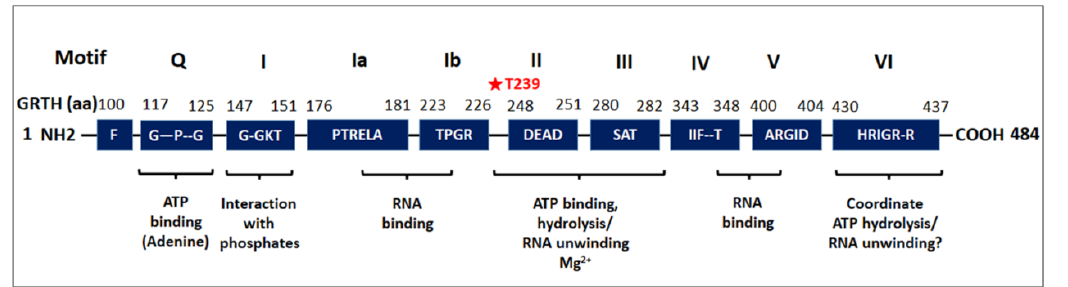
Figure 3. Schematic representation of the conserved motifs of the DEAD-box family of RNA helicase present in GRTH. Nine conserved motifs of GRTH protein were indicated as Q, I, Ia, Ib, II-VI. Amino acid positions of GRTH corresponding to each conserved motif are indicated on top of each motif. Aside from the conserved motifs, GRTH displays low amino acid similarity with other DEAD-box family of RNA helicases. Amino acids within the conserved motifs are specified by their letter code. Among the several serine and threonine residues in the GRTH, only T239 is phosphorylated by PKA (which is highlighted by a red asterisk).